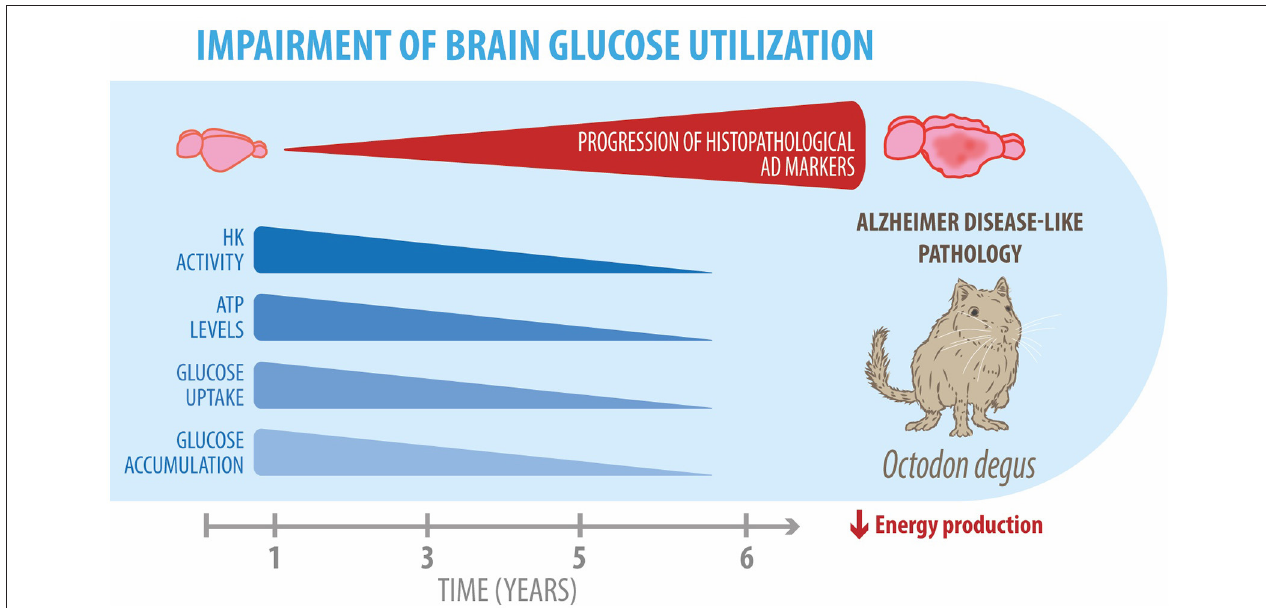
FIGURE 5 | Impairment of brain glucose metabolism in degus. Our data revealed an age-related progressive reduction in several glucose metabolic processes, such as hexokinase expression and activity, ATP levels, and glucose uptake and accumulation in the brains of 5- and 6-year-old degus. Overall, these alterations result in an energetic production deficit, which exacerbates neuroinflammation and neurodegeneration in aged